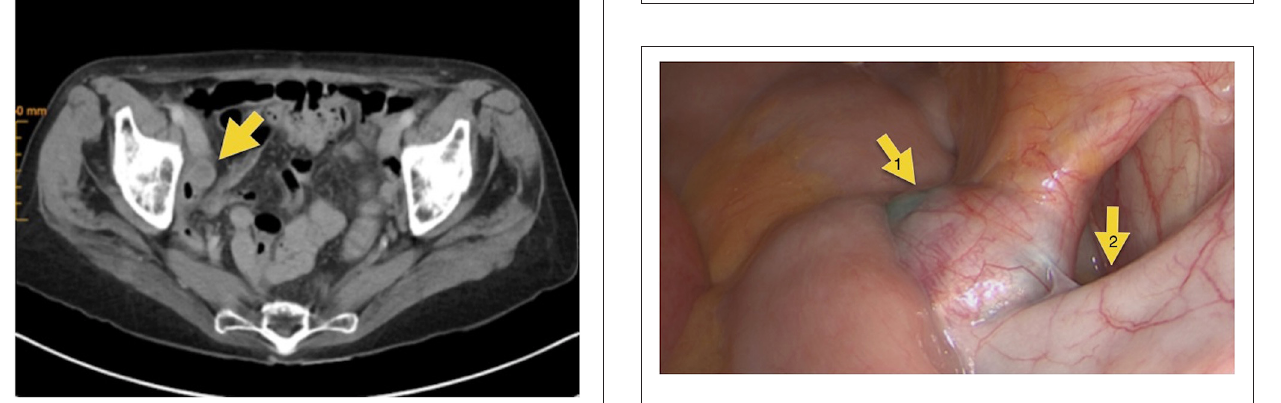
FIGURE 2 | Computer tomography guided ICG injection into the suspected lesion.